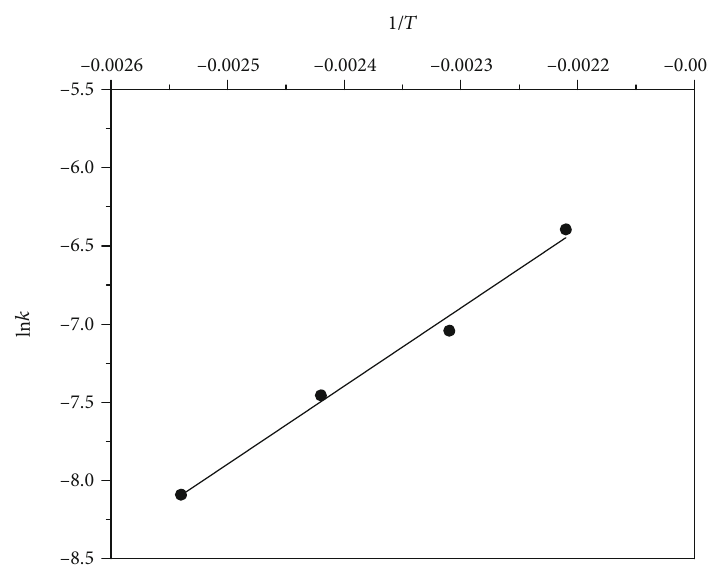
Figure 6: Linear fi tting plot of ln k with 1/ T of reaction constants of BTCA and